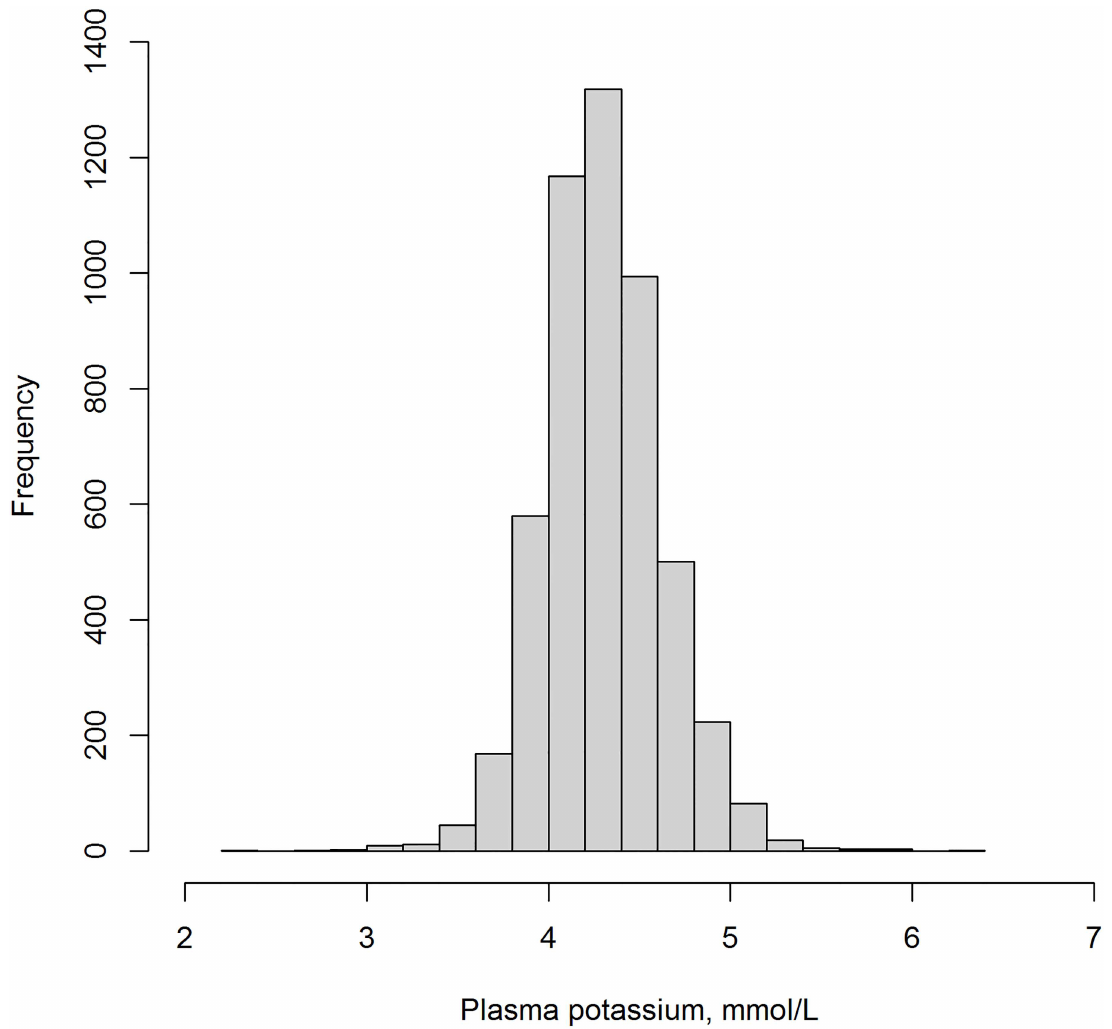
Fig 1. Distribution of plasma potassium in 5,130 subjects of the Prevention of Renal and Vascular End-Stage Disease (PREVEND) study.